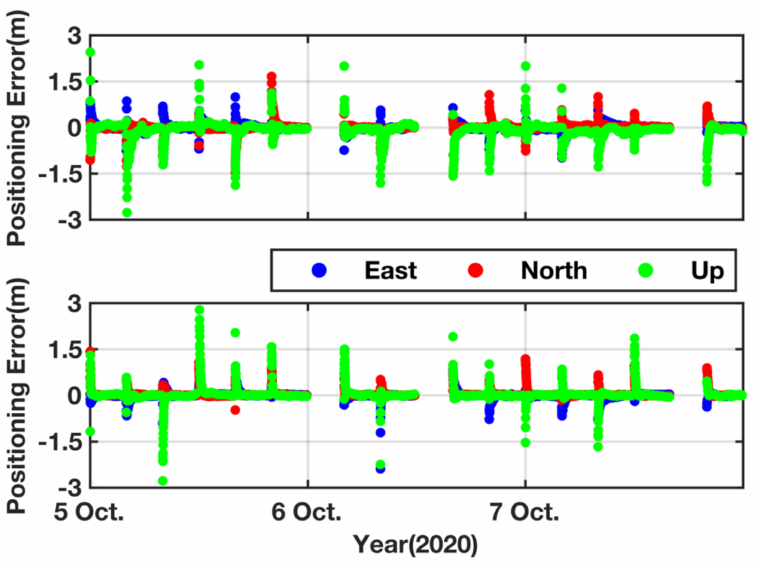
Figure 16. Kinematic PPP positioning errors at the WUH1 station (top panel for PPP-B2b and bottom panel for